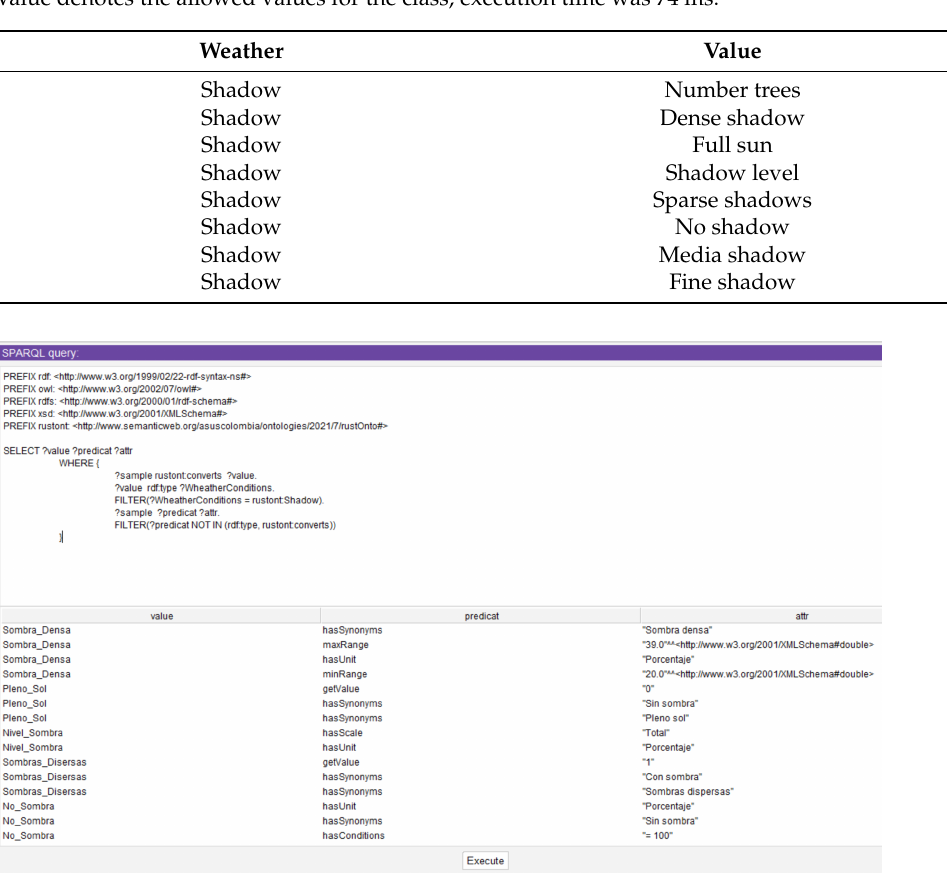
Figure 7. Query in SPARQL detailing the attributes of the supported values for the Shadow variable (Protégé 5’s Pellet reasoner, execution time was 194 ms). Table 11. Result of the query for Scenario 4. Each sample line shows the values accepted for the weather variable Temperature (Protégé 5’s Pellet reasoner, execution time was 110